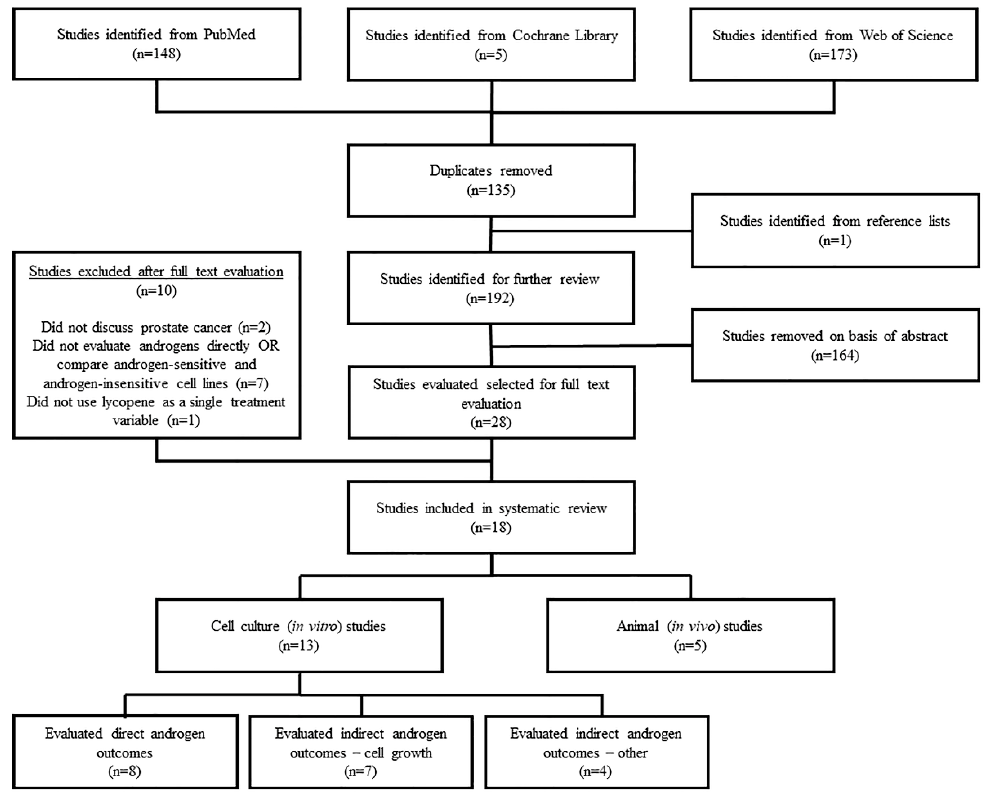
Figure 1. Literature search and study selection flow chart.